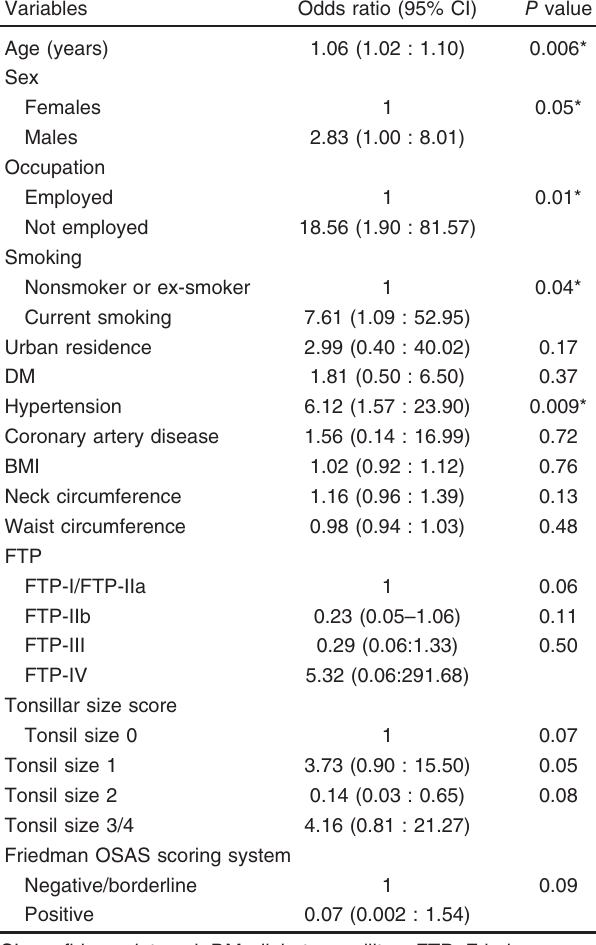
Table 4 Multivariate analysis of predictive factors for obstructive sleep apnea Variables